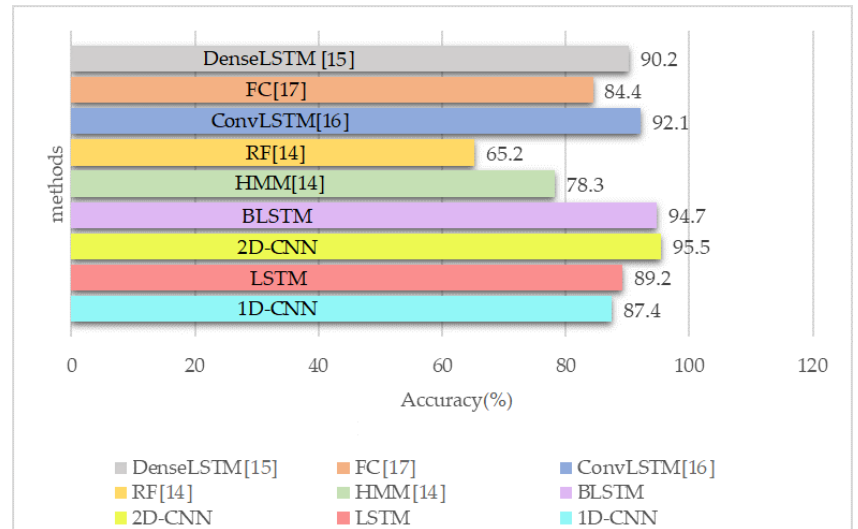
Figure 8. Accuracy of different methods implemented on the